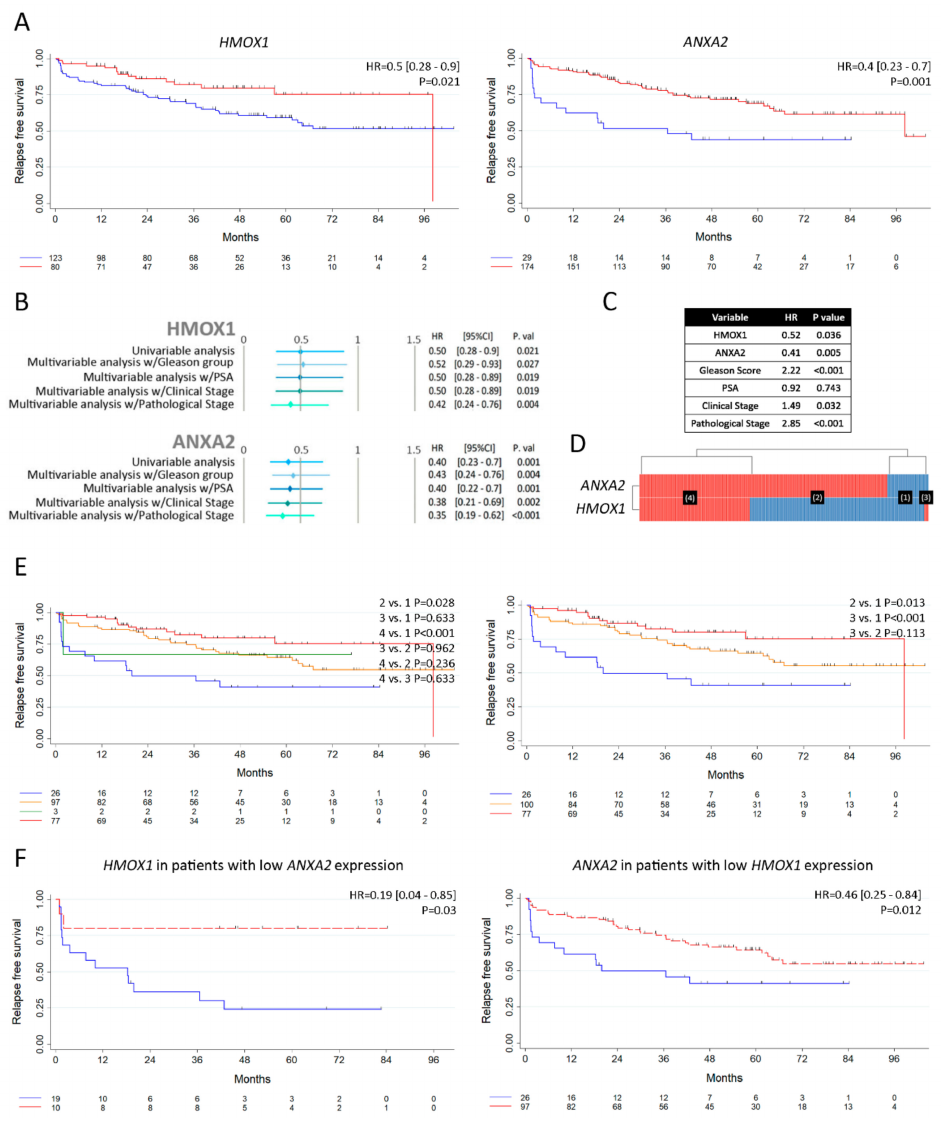
Figure 6. Analysis of HMOX1 and ANXA2 as risk predictors of clinical outcome in PCa. ( A ) Kaplan–Meier (KM) curves for relapse free survival (RFS) (months) and risk table for PCa patients with high (red) or low (blue) expression of HMOX1 and ANXA2 in Ross-Adams dataset ( n = 206). Low expression group was taken as a reference group. Logrank P, HR: Hazard ratio [95% confidence interval] and Cox P are specified. ( B ) Univariable and multivariable analyses are presented by forest plots for relapse free survival regarding HMOX1 (upper panel) or ANXA2 (lower panel) expression. Multivariable analysis w / Gleason group = adjusted for Gleason groups (6; 7 (3 + 4); 7 (4 + 3); 8-10). Multivariable analysis w / PSA = adjusted for PSA serum levels at diagnosis (PSA groups (ng / mL): <